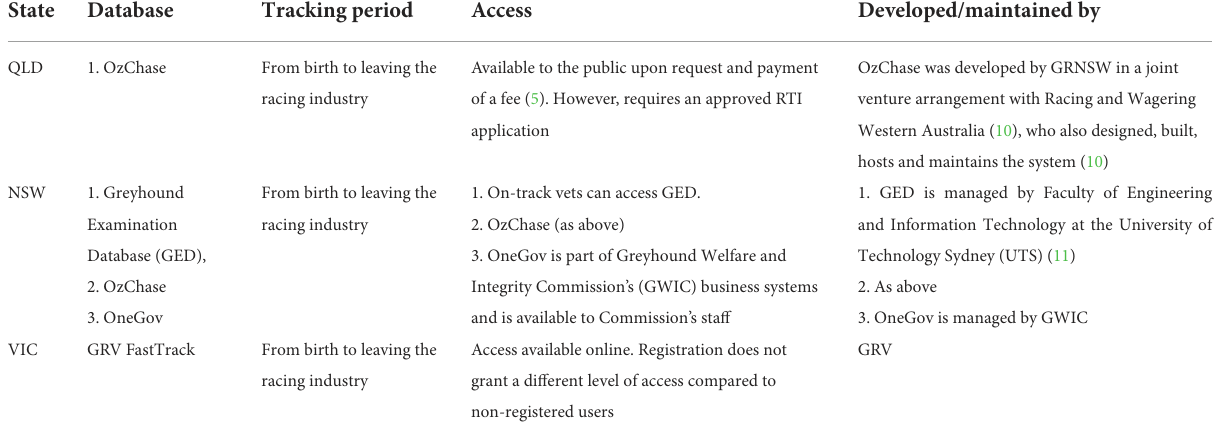
TABLE 3 Databases used for greyhound